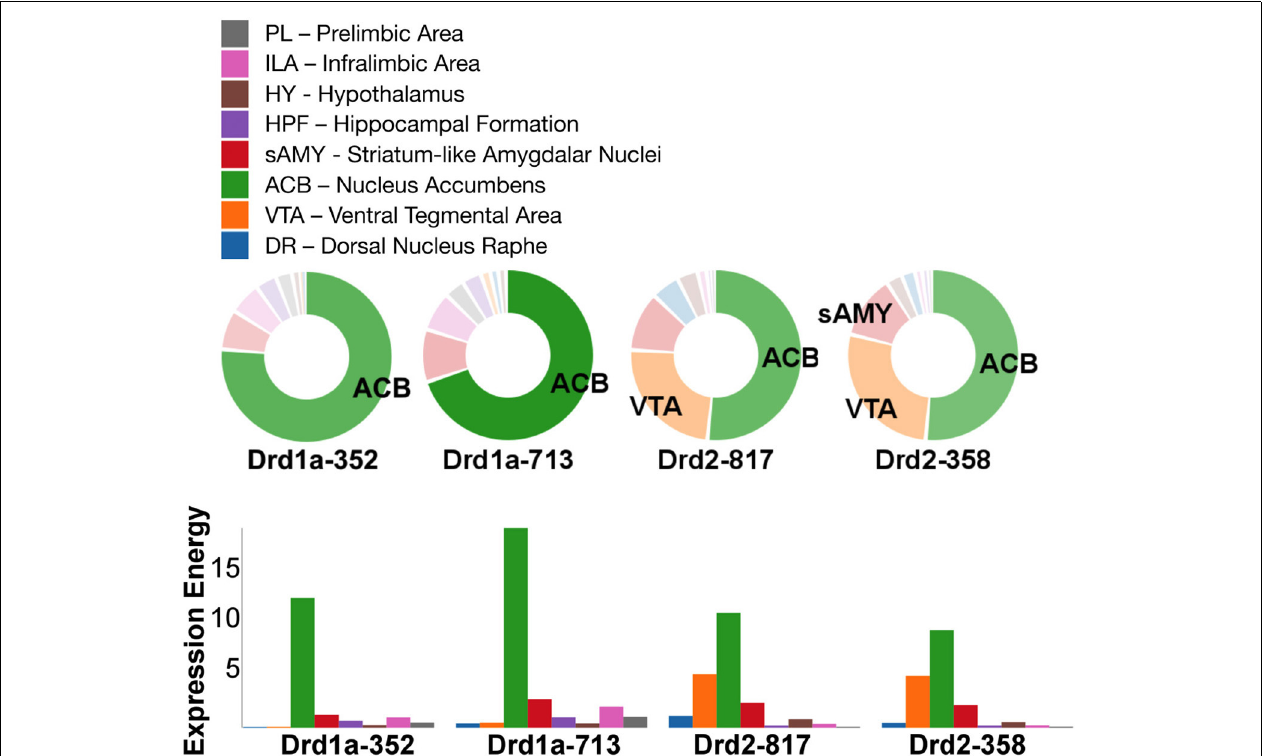
FIGURE 4 | ABADV Pie and Bar Chart of Dopamine Receptor Genes in Brain Structures Associated with Reward Processing. (Top) Each pie represents a different gene, while the slices within a pie represents a different brain structure. Opacity of each pie slice denotes the amount of expression energy relative to other gene expression experiments. Size of pie slice denotes the amount of expression energy relative to other brain